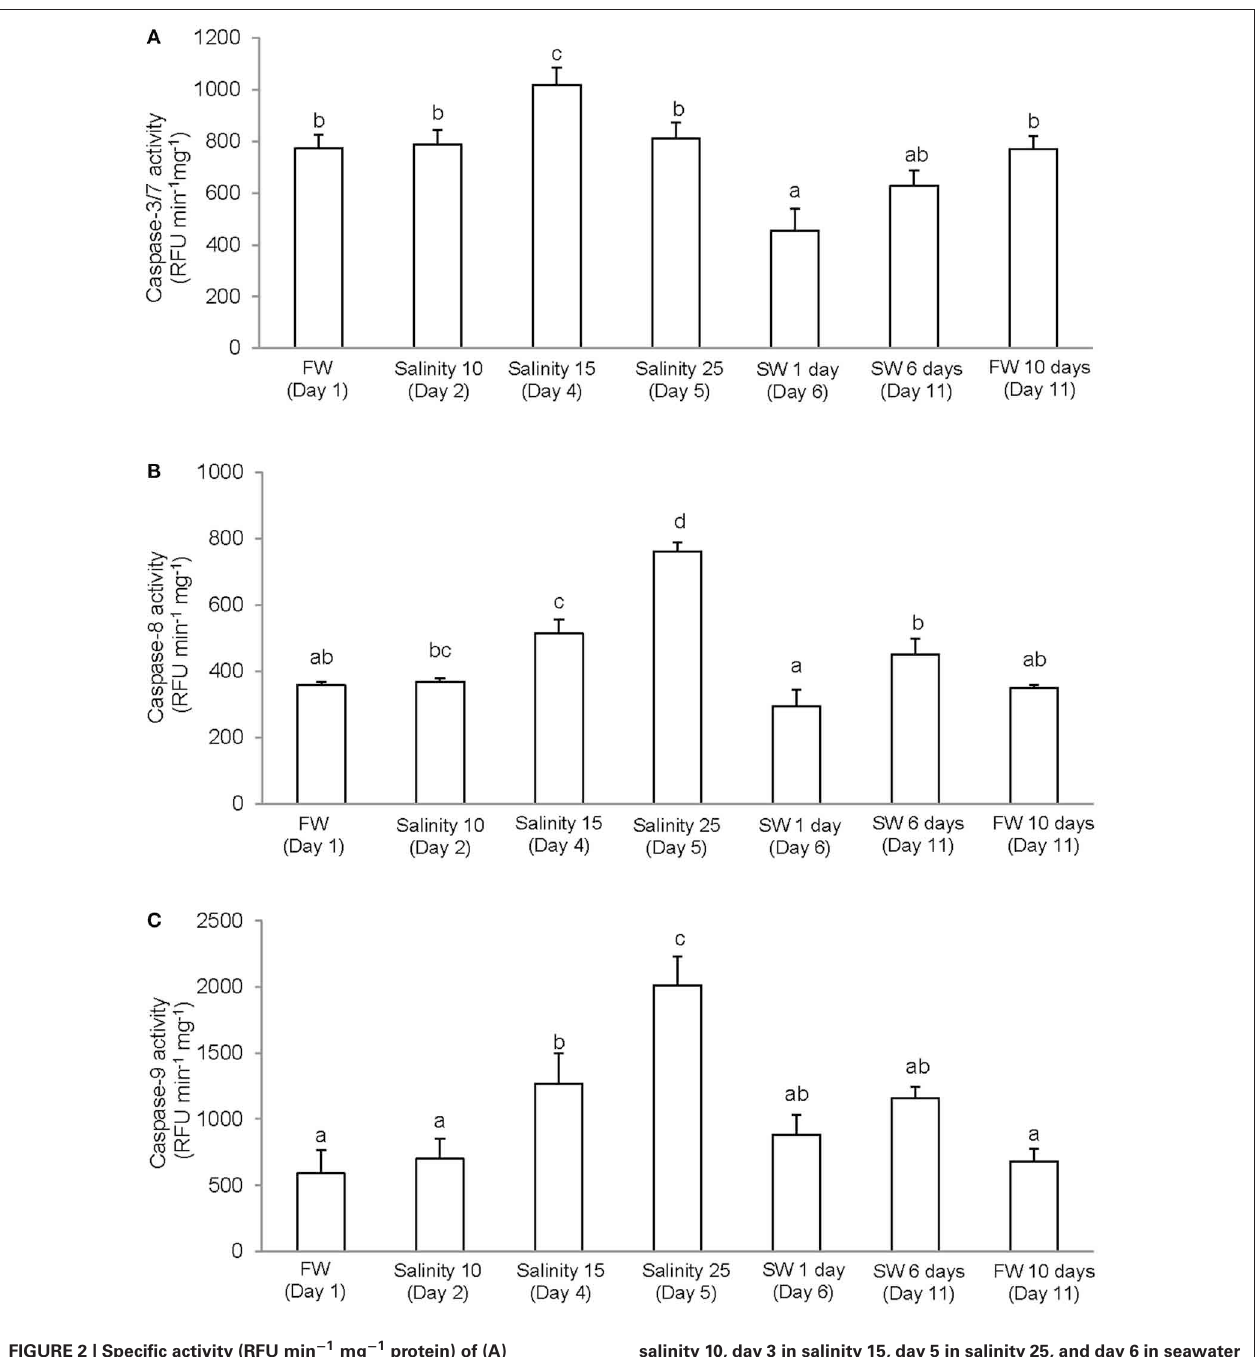
salinity 10, day 3 in salinity 15, day 5 in salinity 25, and day 6 in seawater (SW; salinity 30), followed by acclimation in seawater for another 5 days (day 11). Values are means + S.E.M. ( N = 4). Means not sharing the same letter are significantly different ( P < 0 .